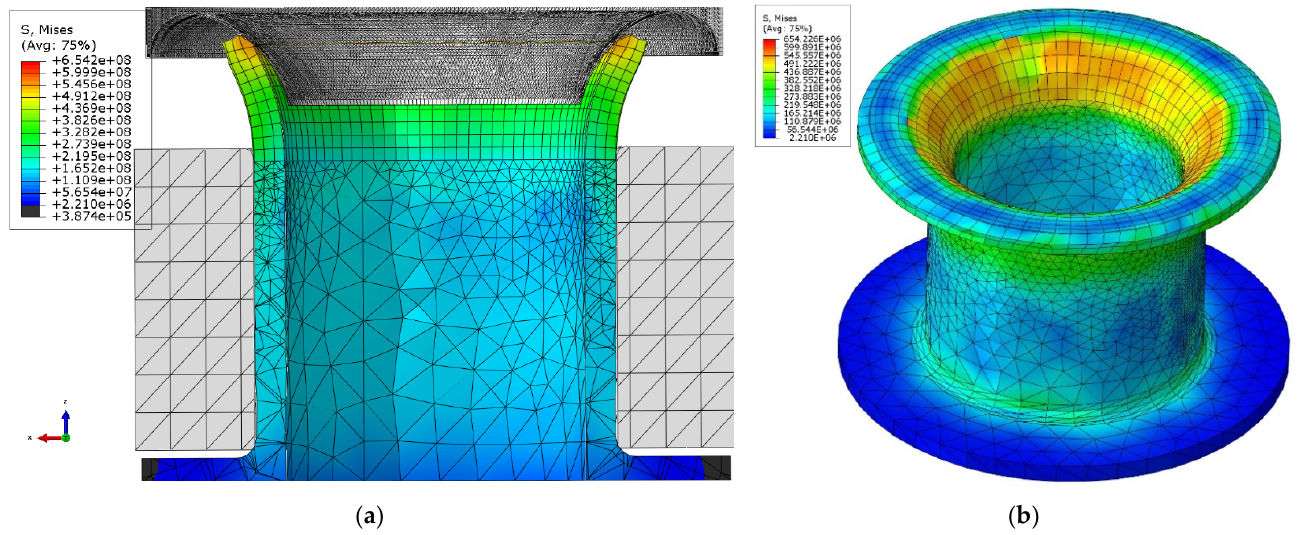
Figure 5. FEM simulation results ( a ) rivet cross ‐ section of the rivet and tool with modified geometry during the riveting process, ( b ) final result after riveting.